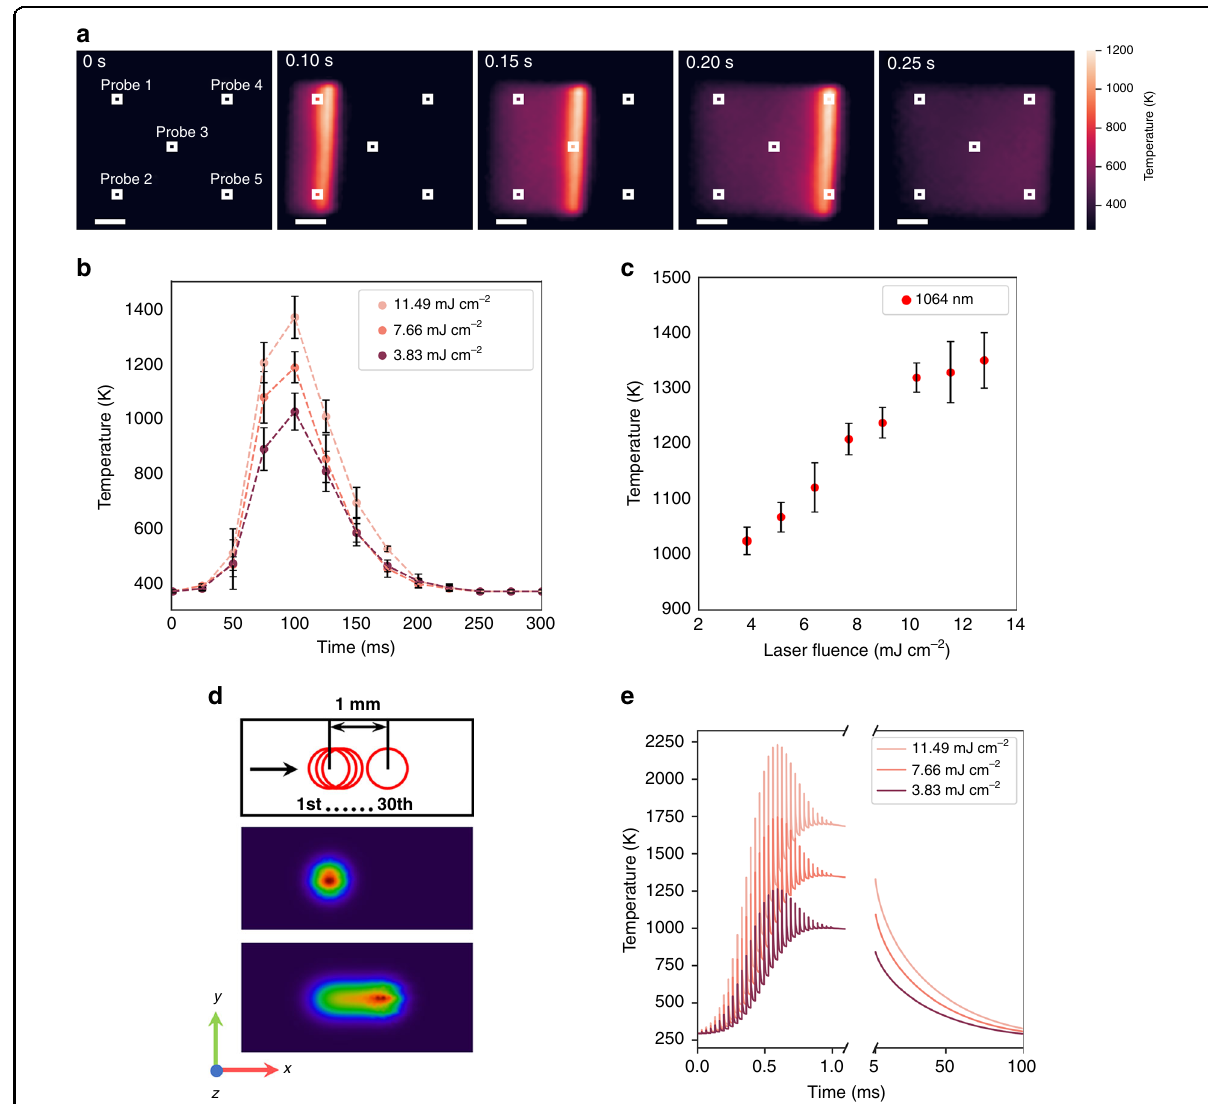
Fig. 5 Thermal pro fi les of the EGO fi lms under irradiation with different laser fl uences. a The infrared images of EGO under 1064 nm laser irradiation at an average power of 6 W and at a scanning speed of 1000 mm s − 1 (the scale is 2.5 mm); b typical temporal thermal pro fi les at an incident laser fl uence of 3.83, 7.66, and 11.49 mJ cm − 2 , respectively. c The change of the measured peak temperatures with the variation of laser fl uences under at a scanning speed of 1000 mm s − 1 . d Schematic of 30 successive laser pulse train irradiated on the EGO surface in COMSOL modeling, and the temperature fi elds on the top surface of EGO fi lm after the fi rst and the thirtieth pulse irradiation. e COMSOL modeling of the EGO fi lm processed by 1064 nm laser at various laser fl